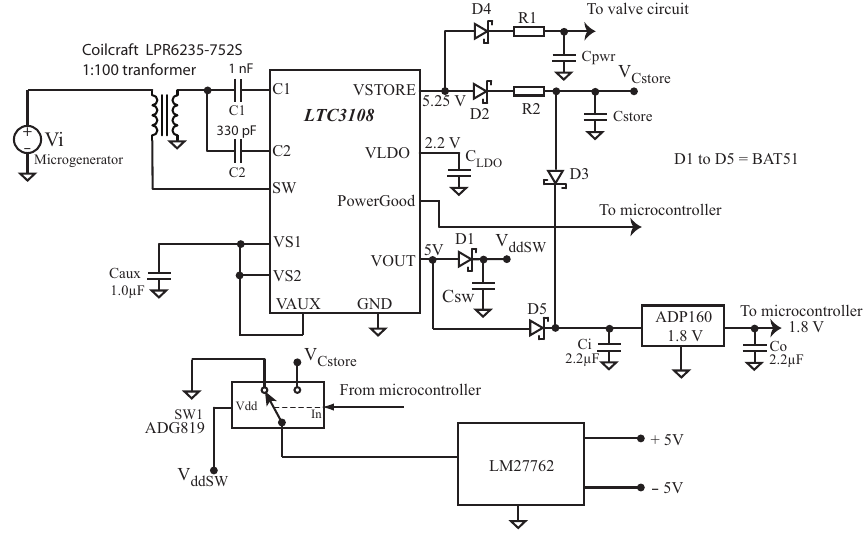
Figure 7. Schematic of the energy harvesting